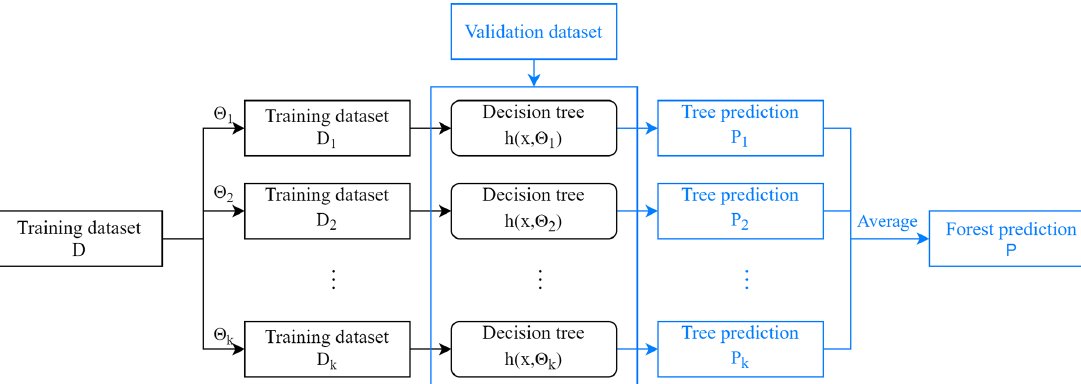
Figure 4. The training and prediction process of the RF regression model.